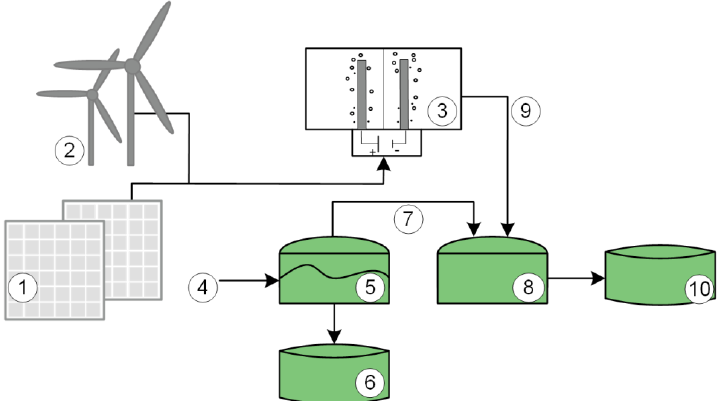
Fig. 1. The conceptual system of renewable electricity accumulation by power-to-gas and power-to-liquid concepts using hydrogen to upgrade biogas to